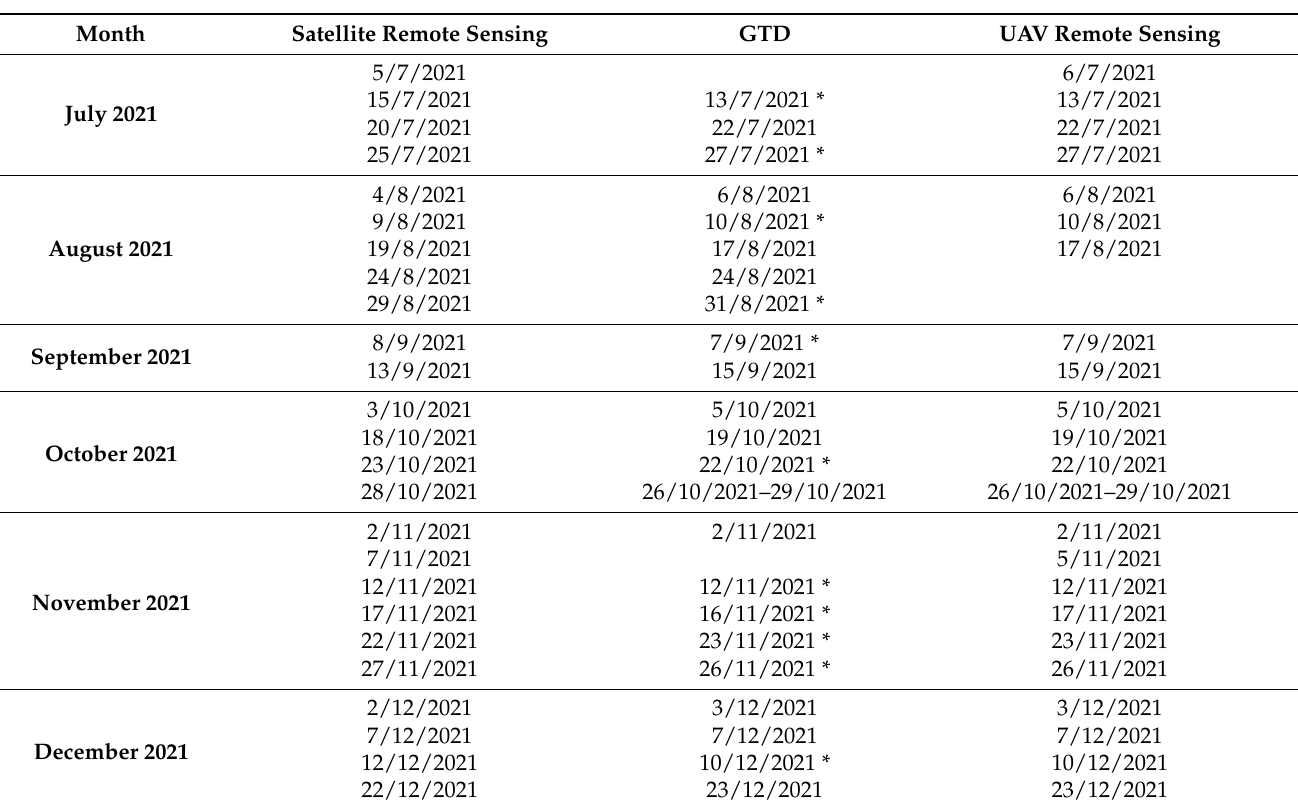
Table 4. Data acquisition date and time of satellite, GTD, and UAV remote sensing. The GTD dates with an asterisk (*) are data without satellite remote